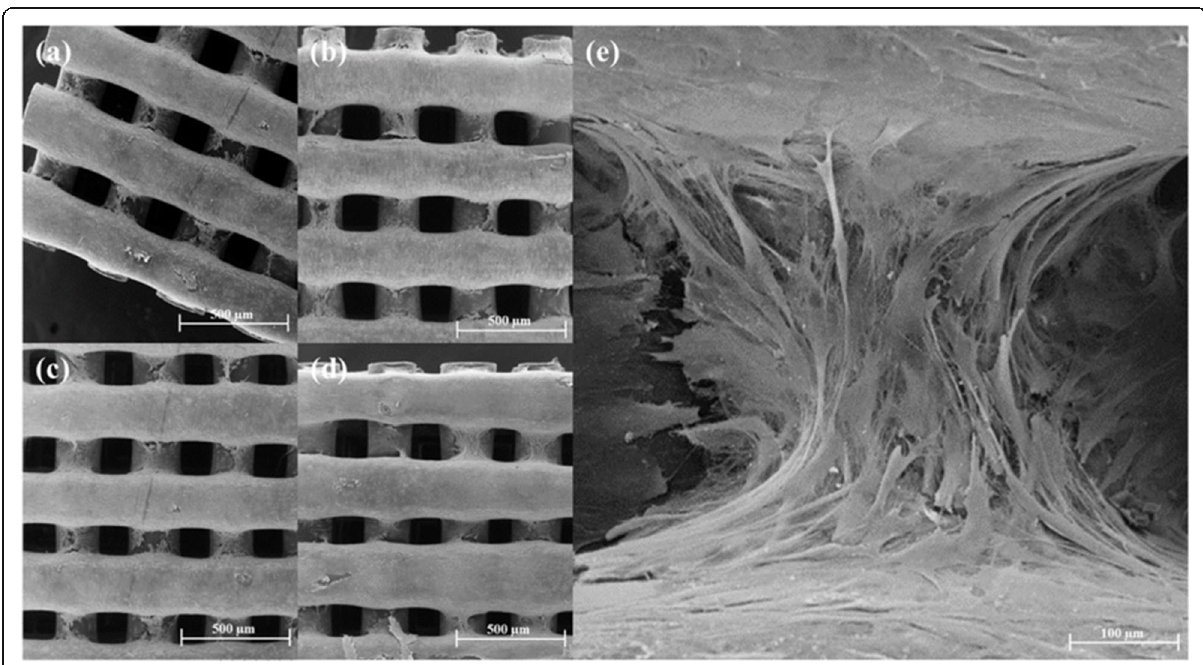
Fig. 8 SEM images of cell seeded scaffolds after 14 days. a PCL; b PCL/graphene (0.13 wt%); c PCL/graphene (0.50 wt%); d PCL/graphene (0.78 wt%); e Zoom up image for cell bridging. Reproduced with permission from